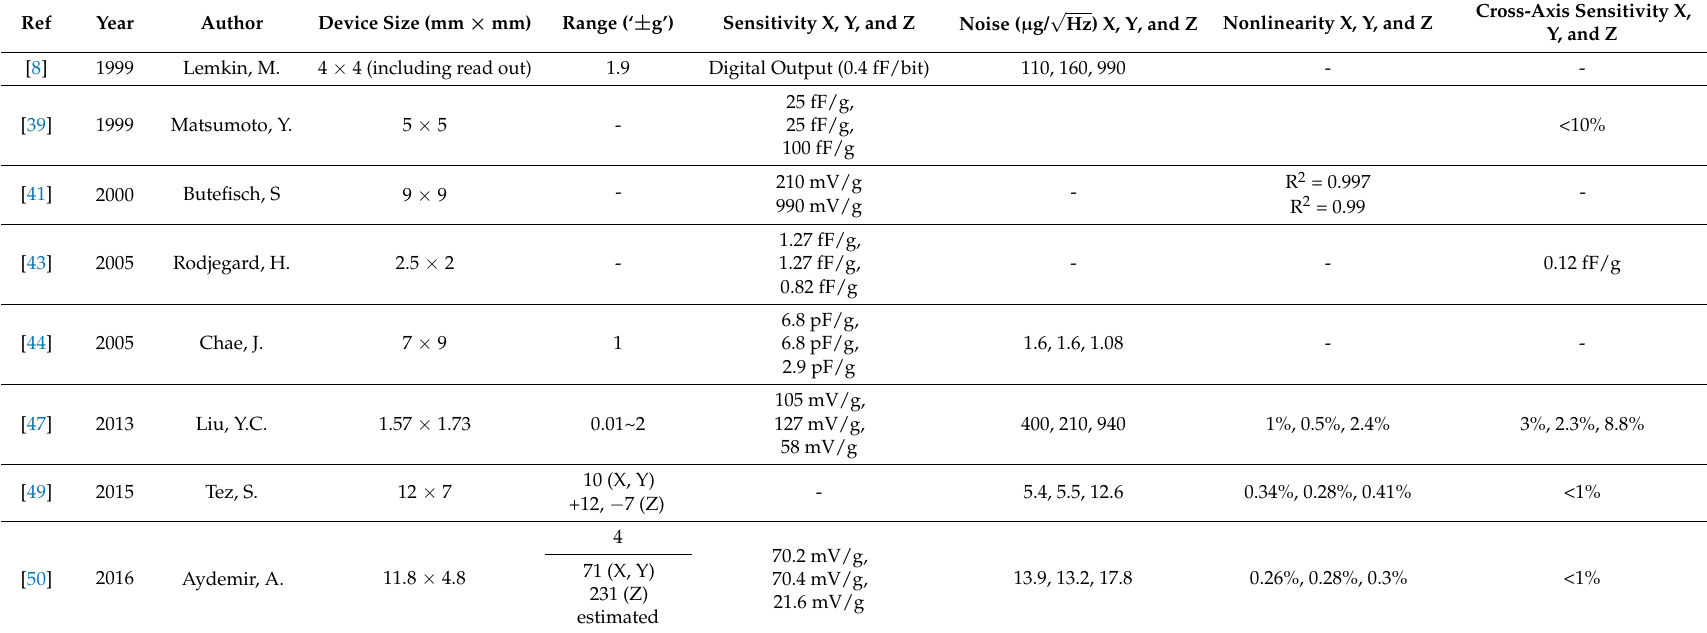
Table 1. Performance summary of tri-axial multiple proof-mass